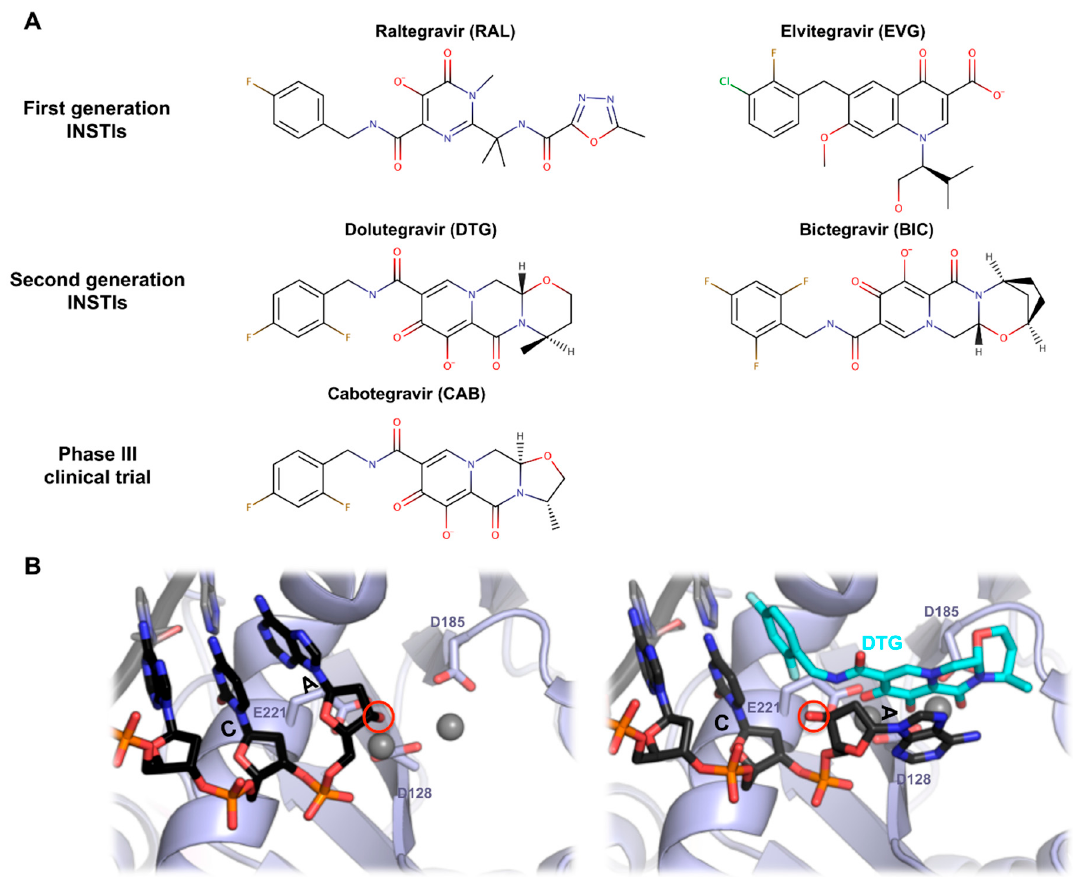
Figure 6. Integrase strand transfer inhibitors. ( A ) Chemical structures of INSTIs. ( B ) Structure of PFV active site with or without DTG. By positioning into the active site, the INSTI engages the metal cofactors and induces a shift of the 3’ reactive hydroxyl (red circle) out of position incompatible for strand transfer.